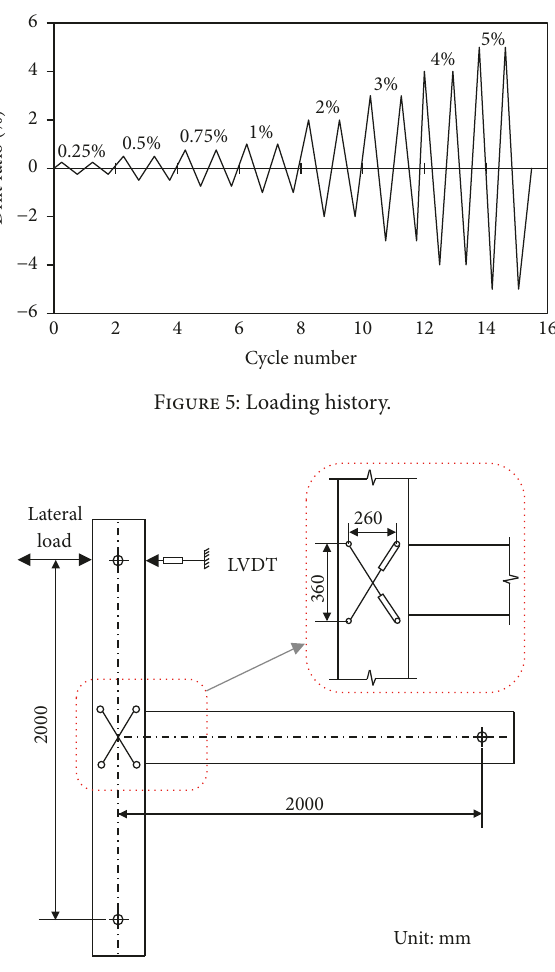
Figure 6: Location of LVDTs in specimens.